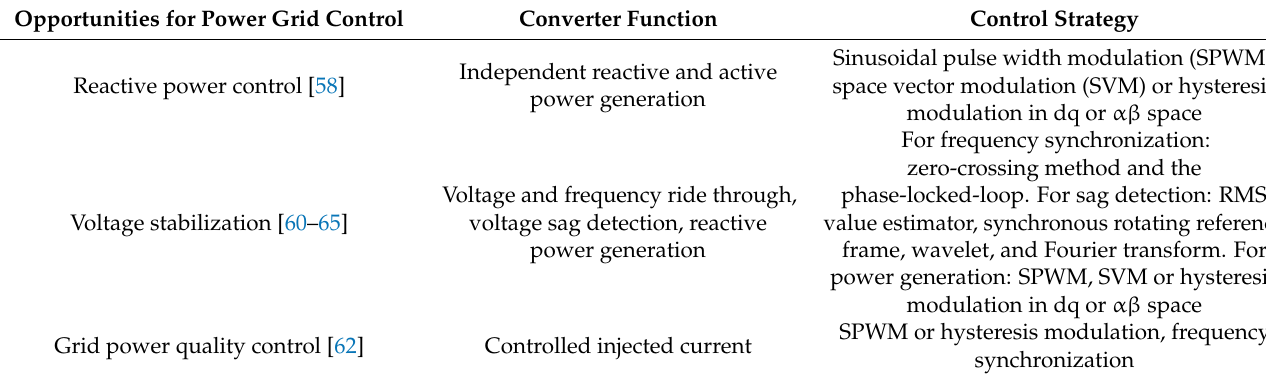
Table 5. List of additional converter functions.